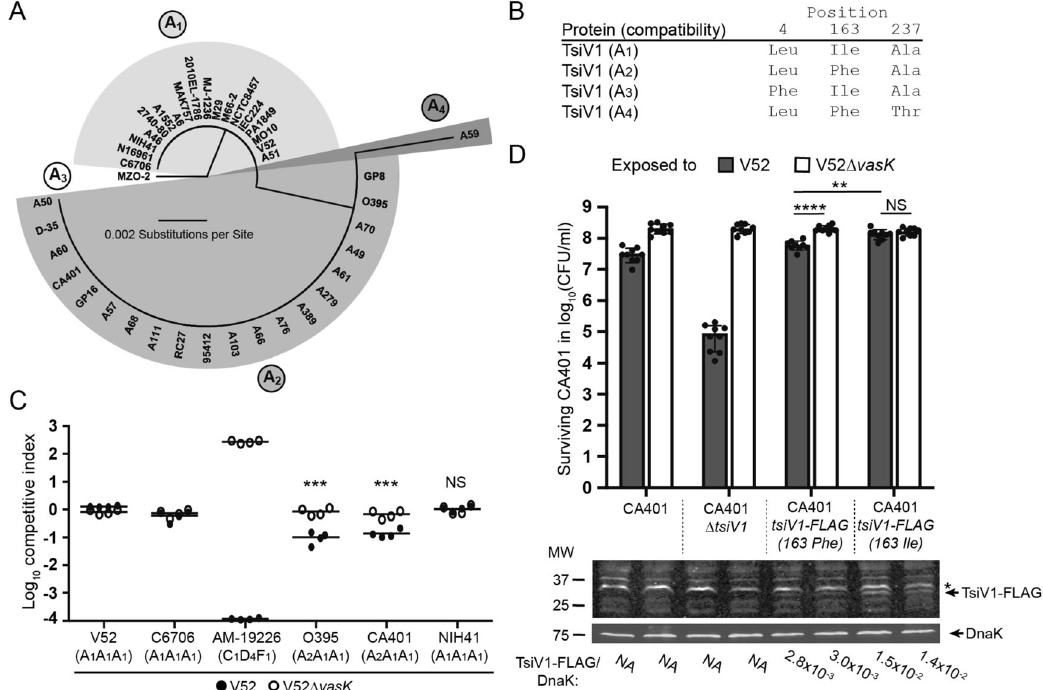
Fig. 3 Classical strains harbour multiple amino acid substitutions in TsiV1. A Amino acid sequences of TsiV1 cluster into 4 groups (A 1 – A 4 ): a radial tree shows the strains that harbour one of four distinct TsiV1 alleles. B Overview of the 4 different TsiV1 sequences: the positions and the respective amino acids that distinguish the sequences are shown. The compatibility group representing the TsiV1 immunity protein in the auxiliary cluster 1 is indicated in parentheses. C Representative classical strains are sensitive to T6SS-mediated attack by the A 1 A 1 A 1 strain V52. V52 or V52 Δ vasK were mixed with the indicated strains in a competition assay at a ratio of 1:1 and incubated for 4 h. The competitive index was calculated by dividing the ratio of indicated strain to V52 determined at t = 4 h by the ratio determined at t = 0 h. The arithmetic mean ± standard deviation of n = 2 independent experiments, each performed in duplicate, is shown. Statistical signi fi cance was determined by a Student ’ s unpaired t -test (*** p = (0.009, 0.013)). D TsiV1 163Ile protects from a T6SS-mediated attack, whereas TsiV1 163Phe does not. V52 was mixed with the indicated strains in a competition assay at a ratio of 1:1 and incubated for 4 h on Lysogeny broth (LB) plates. Mean± standard deviation of 2 independent experiments, each performed in duplicate, is shown. Statistical signi fi cance was determined by a Student ’ s unpaired t -test (**** p = 6.5 × 10 − 6, ** p = 0.0013, ns = not signi fi cant). Prey bacteria from these experiments were incubated alone under identical conditions and a western blot was performed to detect the production of TsiV1 via an anti-FLAG antibody. The ratio of the signal from the FLAG antibody compared with the DnaK loading control is written underneath the respective lanes. For lanes in which a ratio could not be calculated because TsiV1 is not FLAG-tagged in the respective strains, NA (not applicable) was used instead of a ratio. Source data are provided as a Source Data fi